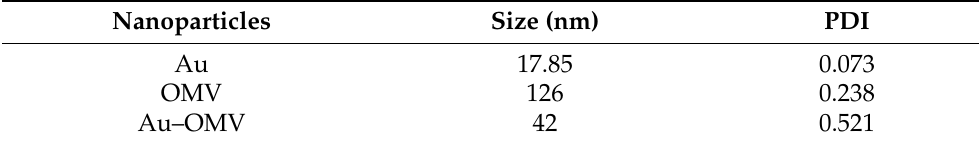
Figure 1. Characterizations of Au–OMV nanoparticles. ( A , B ) Scanning electron microscope image (SEM) of OMV production by E. coli . ( C , D ) TEM images of Au and Au–OMV. Table 1. The size distributions of Au and OMV